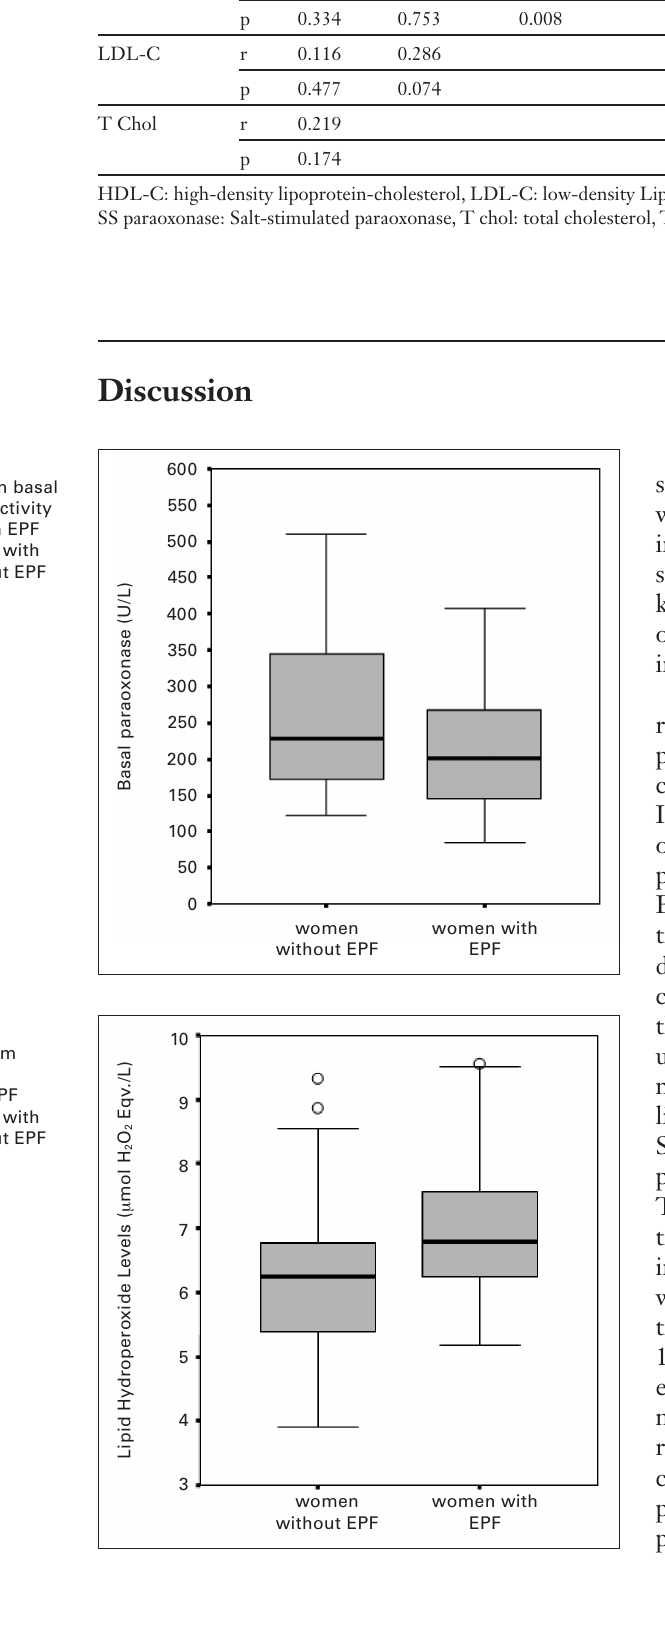
The relationships among the para - oxonase activity, arylesterase activity, SS paraoxonase, LOOH, HDL-C, LDL-C, T chol and TG levels in women with EPF.